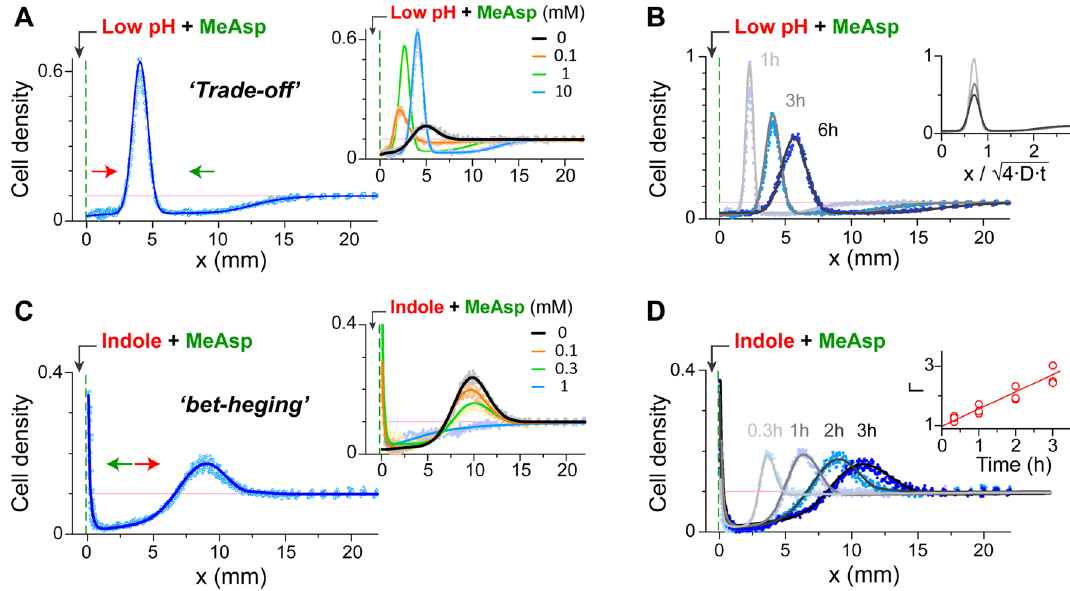
Figure 2. Bacterial distribution near a conflicting source containing MeAsp and either low pH ( A , B ) or indole ( C , D ). ( A ) The bacterial distribution along the channel 3 h after the introduction of a low-pH (4.5) and MeAsp (10 mM) source. Inset —the dependence of the bacterial distribution on the MeAsp concentration in the source. ( B ) The time evolution of the bacterial distribution in the presence of the low-pH (4.5) and MeAsp (10 mM) source. Inset —the bacterial distributions at various times (lines) replotted as a function of the distance from the source ( x ) divided by the corresponding diffusion distance ( D = 7.5 × 10 –6 cm 2 /s). ( C ) The bacterial distribution along the channel 3 h after the introduction of an indole (1 mM) and MeAsp (0.3 mM) source. Inset —the dependence of the bacterial distribution on the MeAsp concentration at the source. ( D ) The time evolution of the bacterial distribution in the presence of the indole (1 mM) and MeAsp (0.3 mM) source. Inset —the integrated bacterial population at the source (integrated fluorescence intensity, in arbitrary units) plotted as a function of time. Throughout, cell density is normalized to the cell density at OD 600 1, and the initial uniform bacterial density (0.1) is marked by the light pink line.